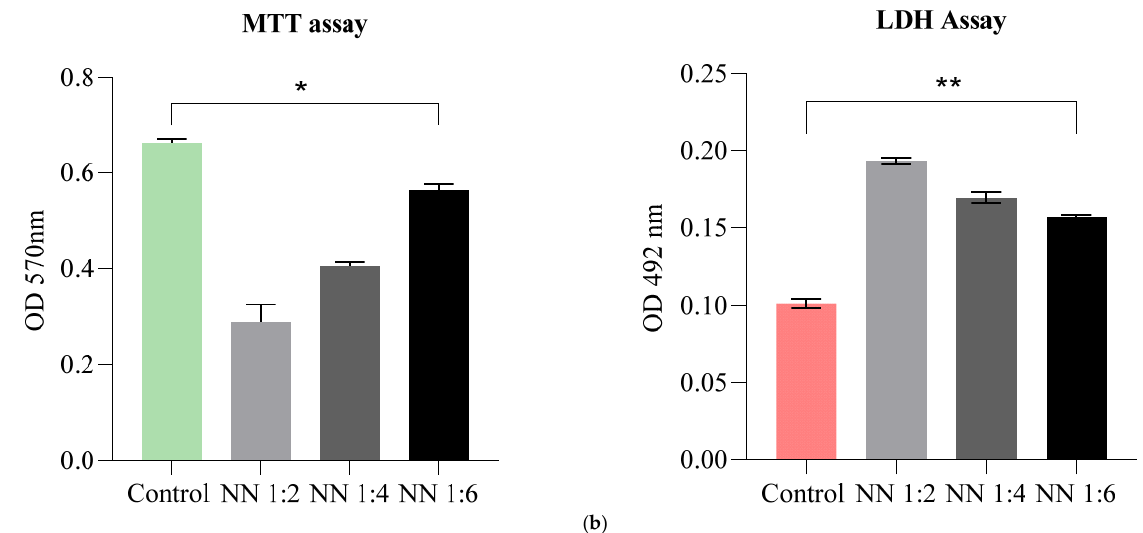
Figure 3. Graphical representation of MTT ( a ) and LDH ( b ) assays results for NN sample of 200 mg/mL, 100 mg/mL and 50 mg/mL concentrations. Control is represented by HT-29 cells in culture LDH p value ** = 0.0042 (highly significant statistically).